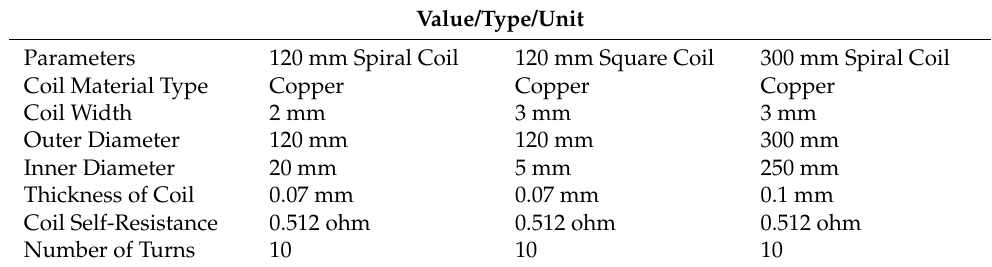
Table 1. Armatures of coil design.